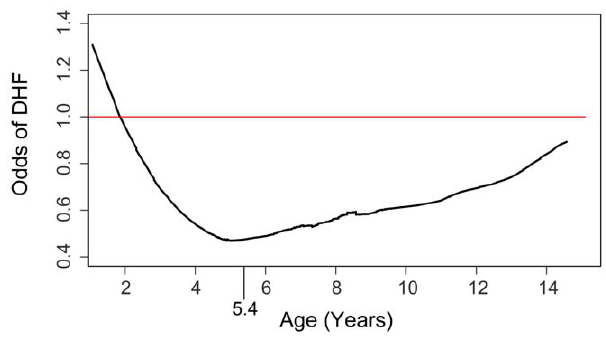
Figure 1. Smoothed lowess plot of odds of DHF vs. age. Odds of DHF upon dengue illness as a function of age (18 months to 15 years). Those not experiencing DHF were diagnosed with DF. A transition point of 5.4 years used to define an indicator variable in regression analyses is shown on the x-axis.